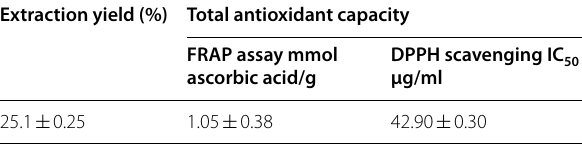
Table 1 Total antioxidant capacity of ethanol extract from OL Extraction yield (%) Total antioxidant capacity